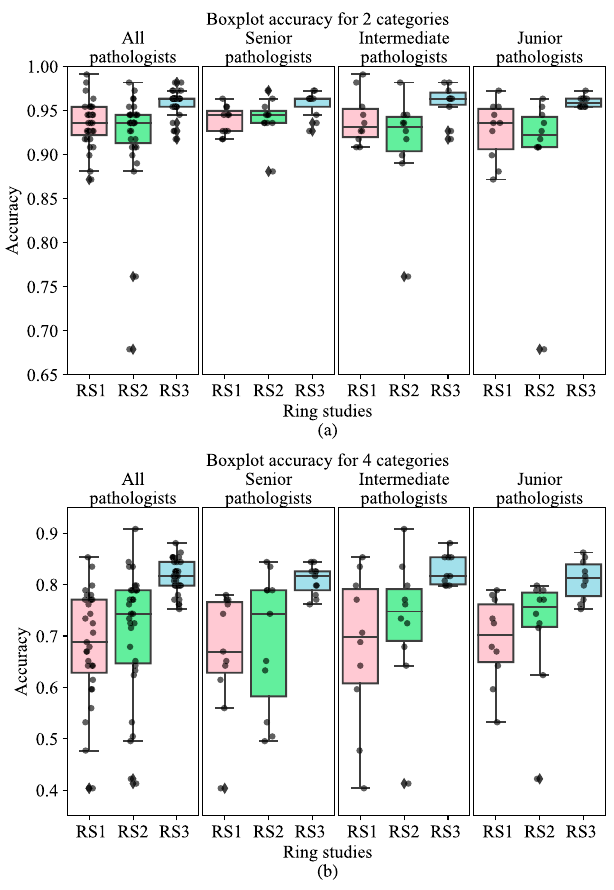
Fig. 4 Boxplots of scoring accuracies in three-ring studies for pathologists in different levels. The center bar of each box represents the median value, and the box body extends from the 25th to the 75th percentile of values in one ring study. Black circles indicate the accuracy of the individual pathologists, and black diamonds indicate the outliers. a 2-category score. b 4- category